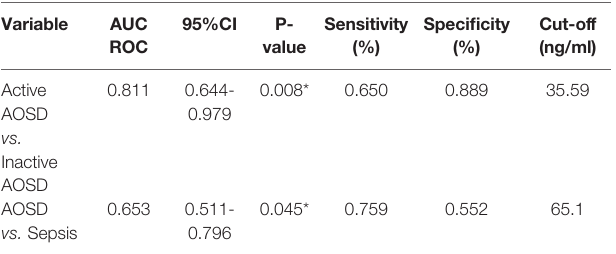
TABLE 4 | Receiver operating characteristic (ROC) curve analysis of the predictive capacity of heparin-binding protein (HBP) to distinguish between active and inactive AOSD and sepsis.